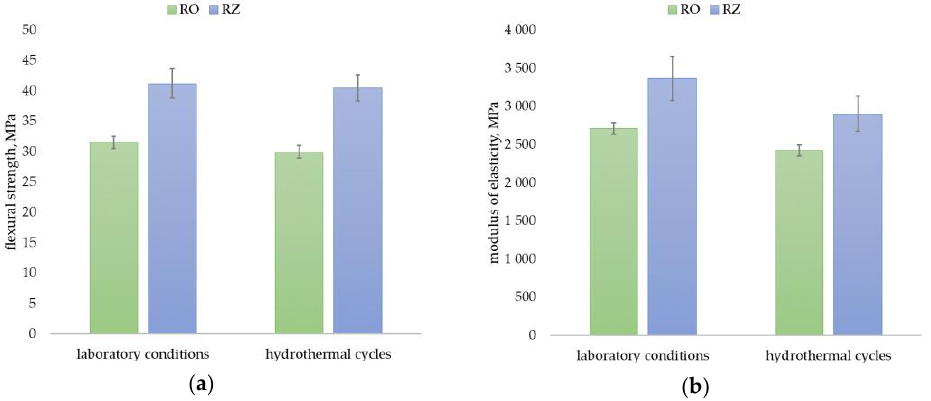
Figure 6. Test results for ( a ) flexural strength, ( b ) flexural modulus. Error bars represent standard